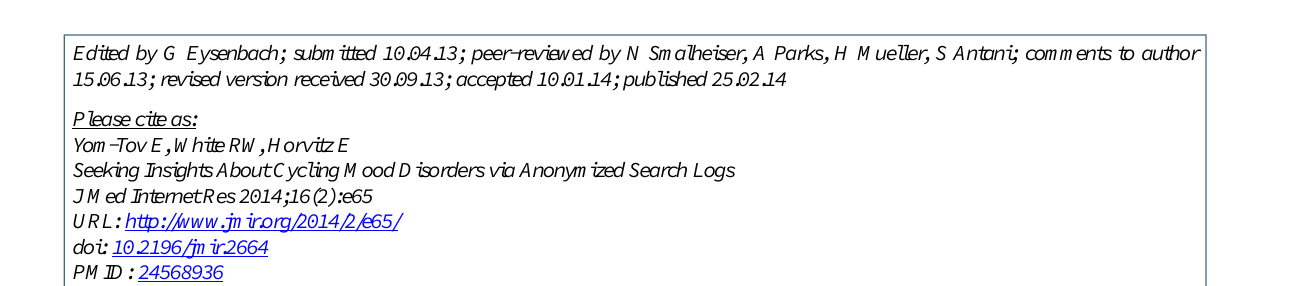
Abbreviations AUC: area under the receiver operating characteristic curve MD: mood disorder MSD: mood stabilizing drug